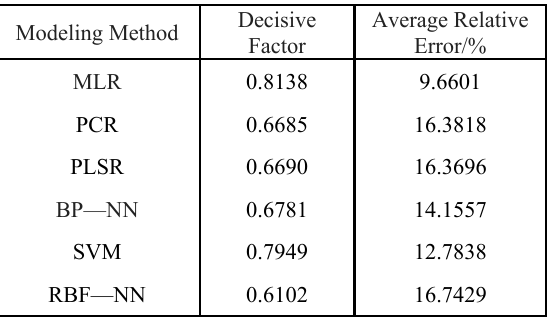
Table 4. Estimation accuracy comparison table of estimation